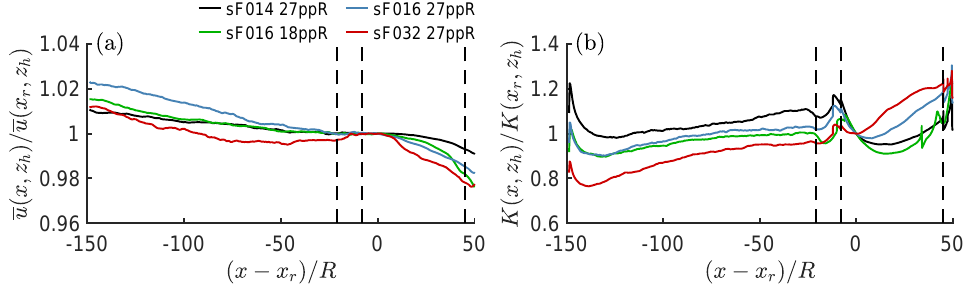
Figure 7. ( a ) Mean axial velocity u ( x , z h ) and ( b ) turbulent kinetic energy K ( x , z h ) as function of the axial distance to the rotor, both normalized to their respective values u ( x r , z h ) , K ( x r , z h ) at the rotor center along the entire domain without turbine. The dashed vertical lines indicate the borders between the regions and the legend denotes flow condition and grid resolution The axial changes are more pronounced for the high roughness ( α = 0.32) case.